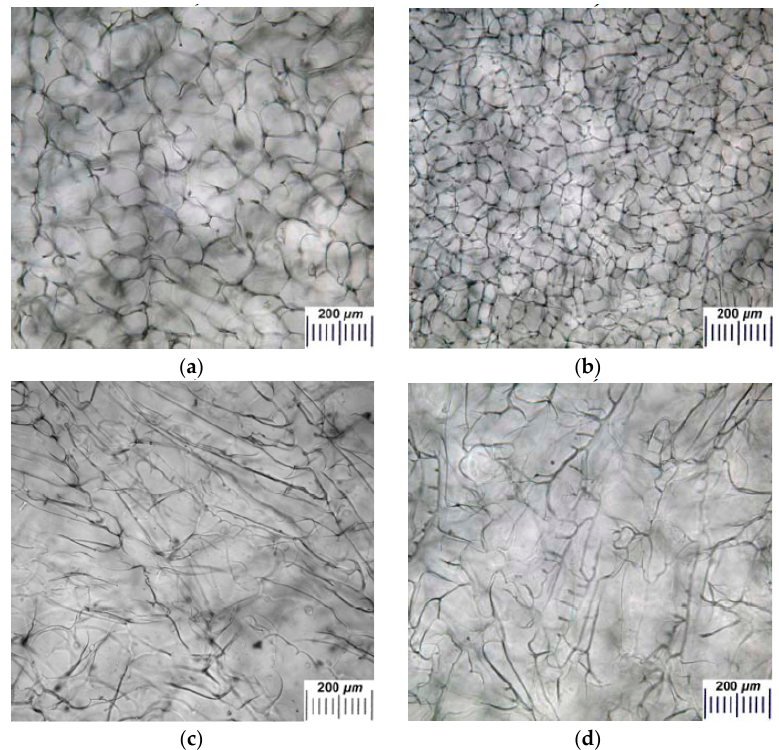
Figure 5. Micrographs (optical microscope) of the water-swollen Ca-ACRS samples formed on the basis of an aqueous Na-ALG solution (30 g / L) by its freezing at the following temperatures: − 10 ◦ C ( a ) the bottom surface of the disk; − 20 ◦ C ( b ) the bottom surface of the disk and ( d ) the top surface disk; and − 30 ◦ C ( c ) the bottom surface of the